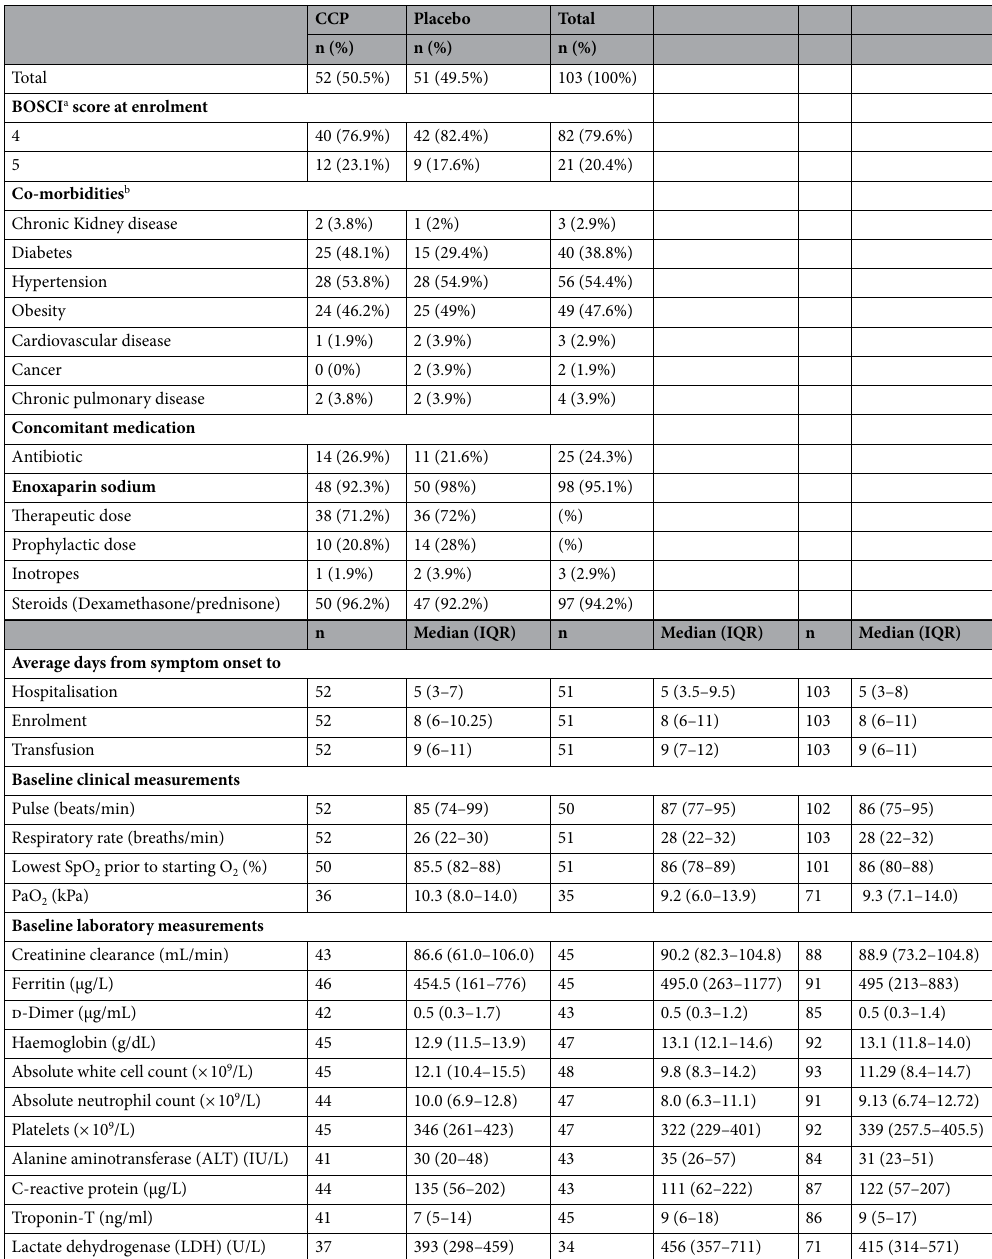
Table 2. Clinical and laboratory characteristics at baseline in 103 participants with severe COVID-19 randomized to treatment with convalescent plasma versus placebo. a Minimum BOSCI score of 4 was required for eligibility. BOSCI 4: hospitalized, mild disease, on oxygen by mask or nasal prongs. BOSCI 5: hospitalized, severe disease, non-invasive ventilation or high flow oxygen. b Comorbidities are listed as number of